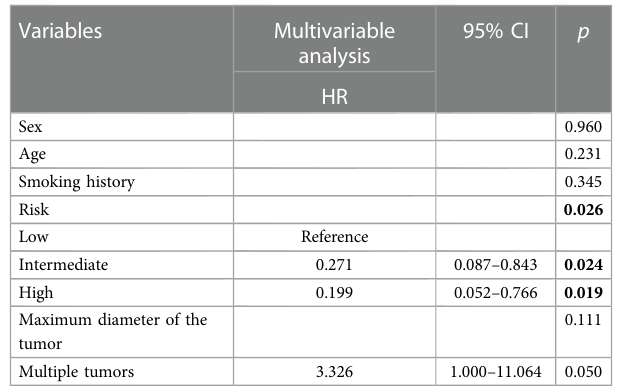
TABLE 4 Multivariable analysis of recurrence-free